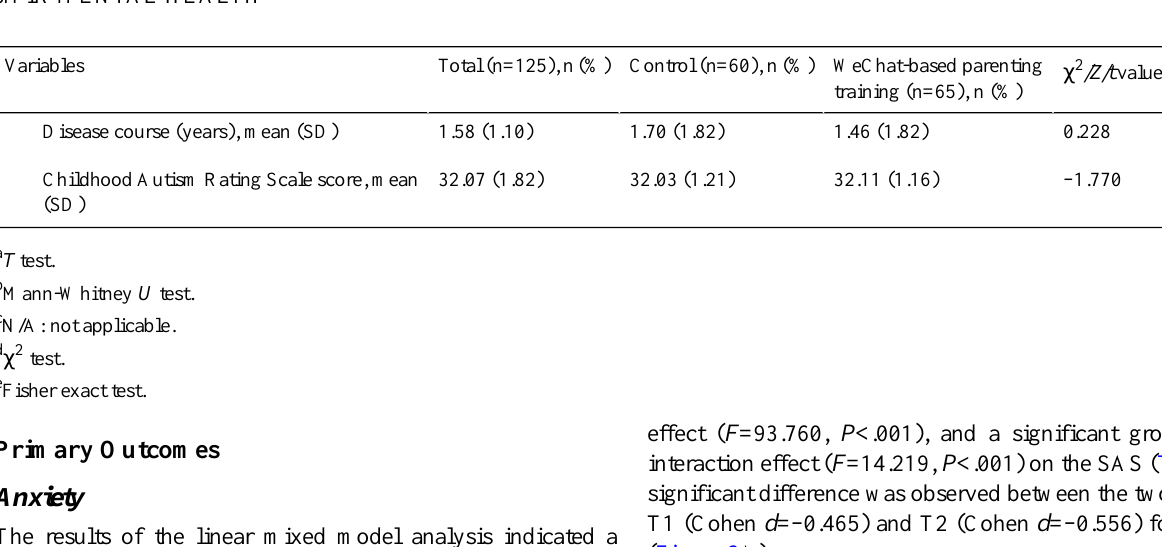
The results of the linear mixed model analysis indicated a significant group effect ( F =4.906, P =.029), a significant time